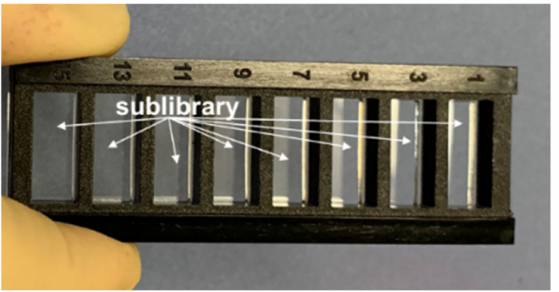
Figure 9. Sublibrary consisting of the substitutions to the peptides selected from the first screens. Eight windows were used to incubate the same sublibrary with different RTX